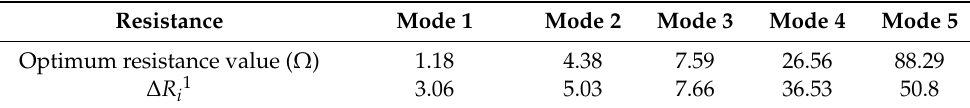
Table 3. Different ∆ R i for different connection methods.